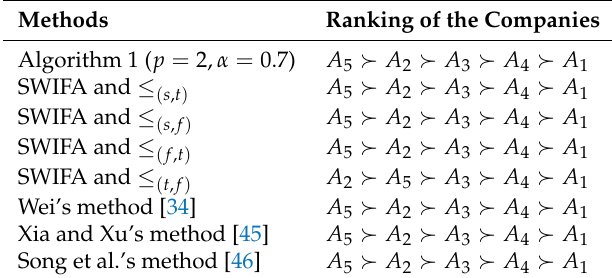
Table 3. Ranking results given by different